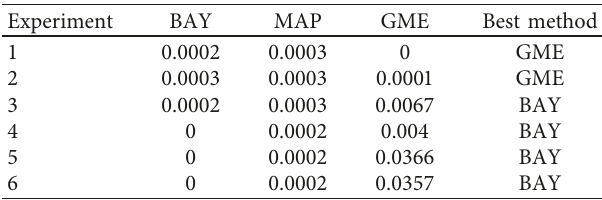
Table 4: Total deviation for the Weibull growth model.